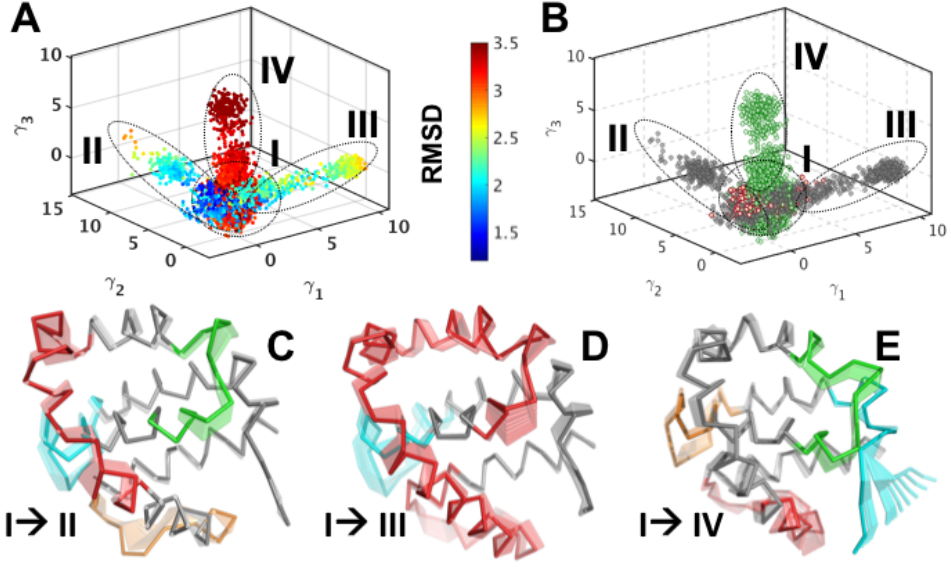
Figure 3. Quasi-anharmonic analysis of apo-M11 simulations indicates how coupled motions in α 2 control the opening and closing of the BH3 binding site. ( A ) Projection of the 1 µ s apo-M11 simulations along the top three anharmonic modes ( γ 1 − 3 ) shows the presence of at least 4 putative substates in the landscape that have distinct structural (and energetic) features. Each conformation in the projection plot is colored accorting to the RMSD with respect to the apo-M11 (2ABO crystal structure) and one can observe the separation between low (blue) and high (green/red) in this low dimensional representation. ( B ) Projection of the holo-M11 simulations (shown in orange dots) onto the subspace spanned by the top three anharmonic modes by the apo- simulations (from the left hand panel) reveal partial overlaps between the apo- and holo-M11 simulations. Notably, the overlaps span areas that have a lower RMSD (blue conformers in the left hand panel) and higher RMSD (green conformers in the left hand panel). ( C – E ) Analysis of the motions encoded in the top three anharmonic modes from the apo-M11 simulations show distinct coupling between the motions of α 2 to that of the opening/closing of the BH3 domain interaction site. The motions are shown in a movie like representation with darker tones showing the initial state and subsequent frames being shown in lighter